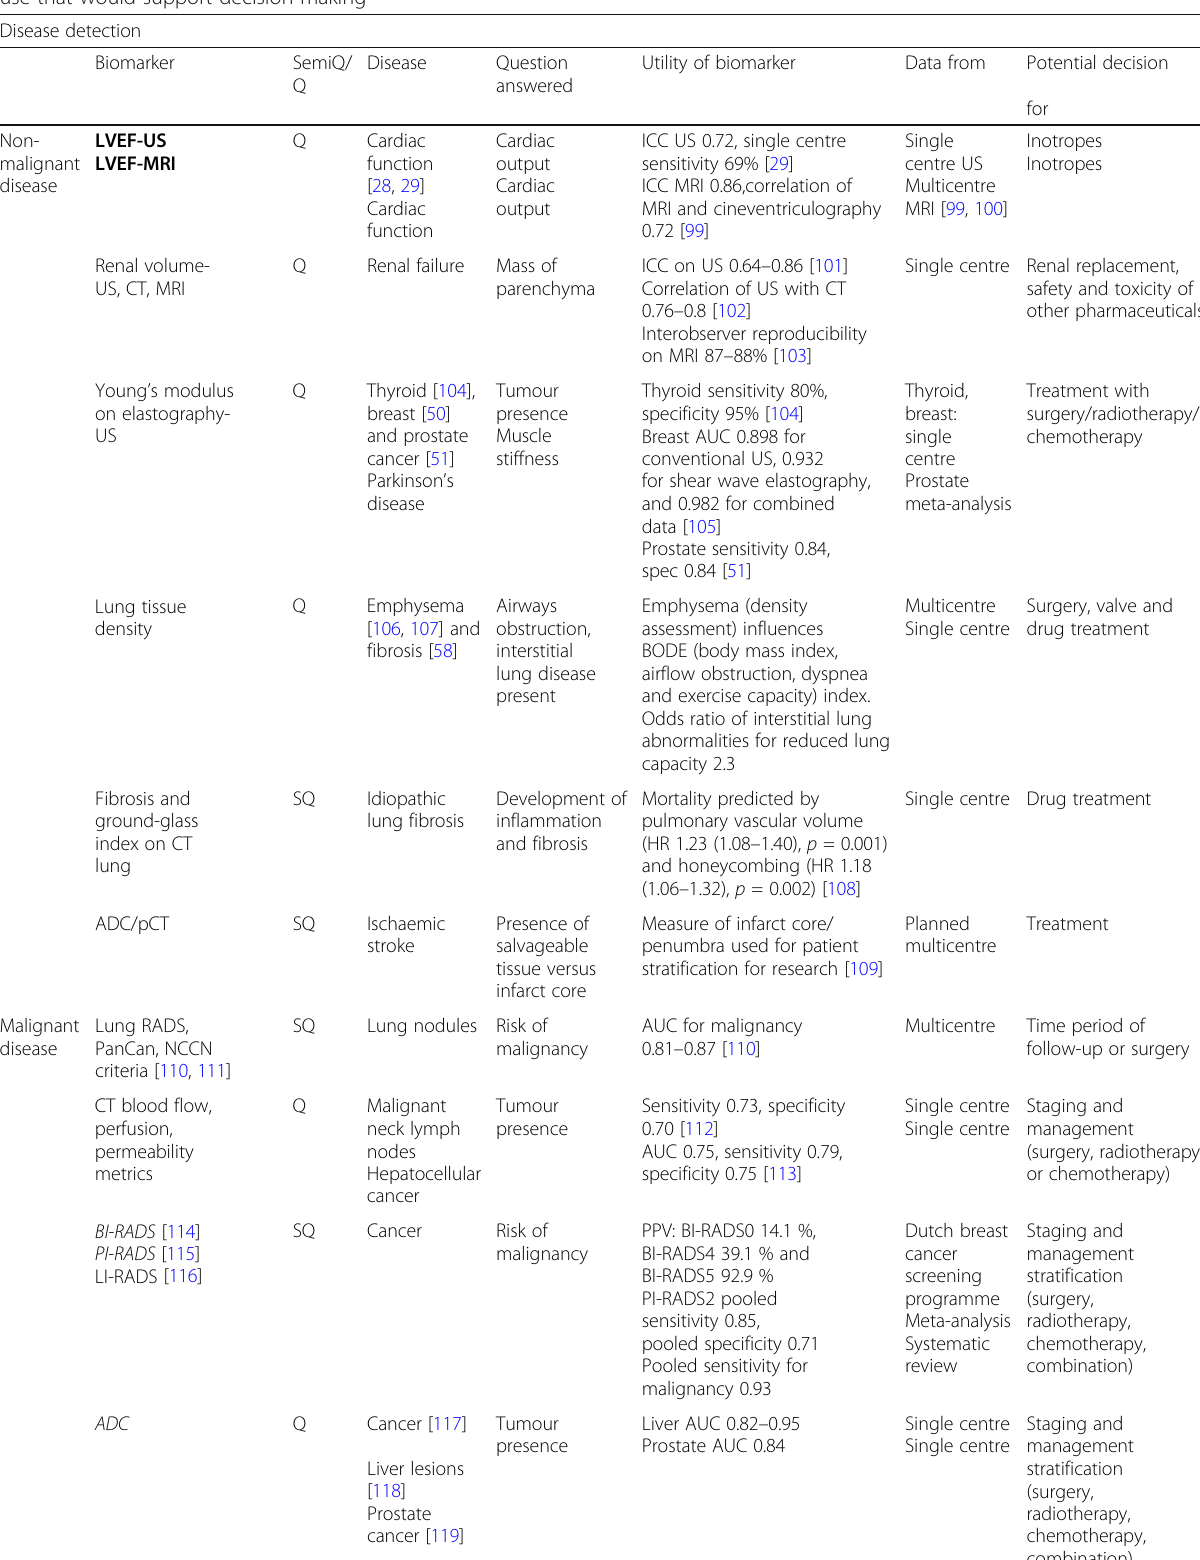
Table 1 Imaging biomarkers for disease detection (semi-quantitative and quantitative) with examples of current evidence for their use that would support